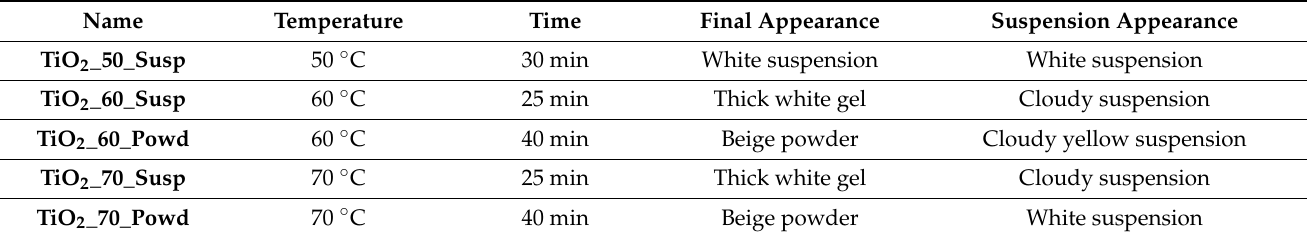
Table 1. Reaction conditions and product appearance of the materials synthesized in this